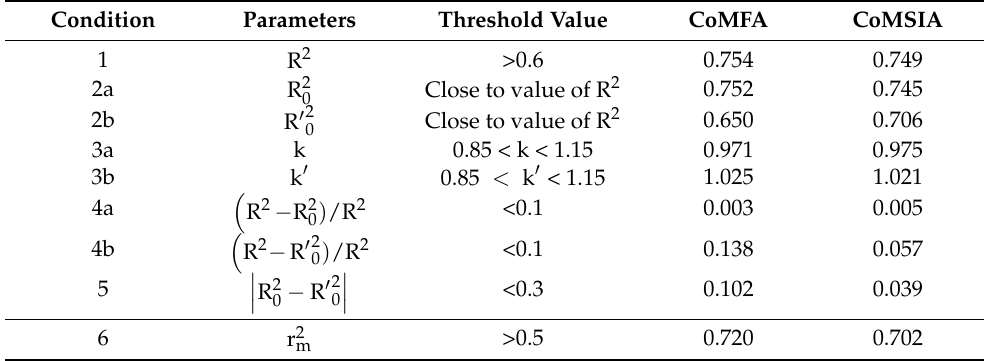
Table 2. The external verification calculation results of the CoMFA and CoMSIA models. Condition Parameters